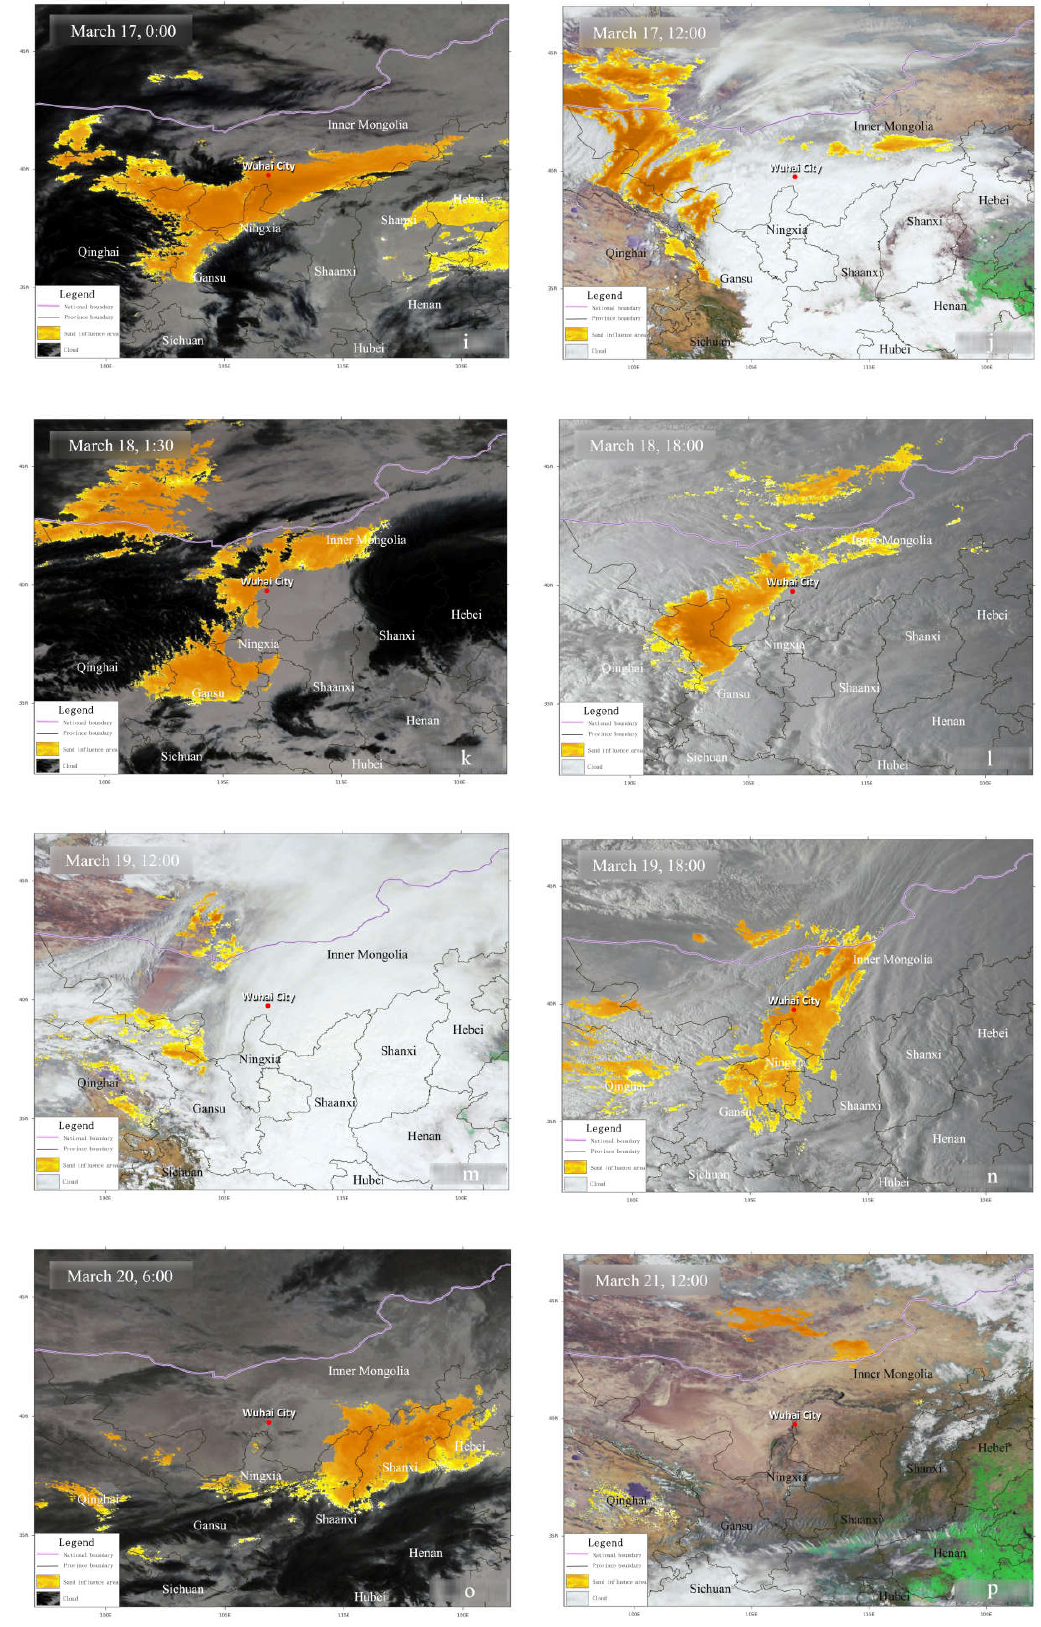
Figure 1. Sandstorm transport process based on remote sensing observations: ( a , b ) sandstorm occurred; ( c – n ) sandstorm continued; ( o , p ) sandstorm dissipation.